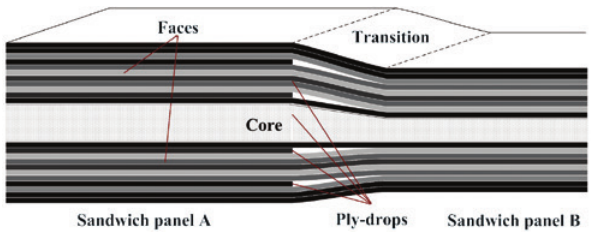
Figure 2: Ply drops between adjacent sandwich panels with different core